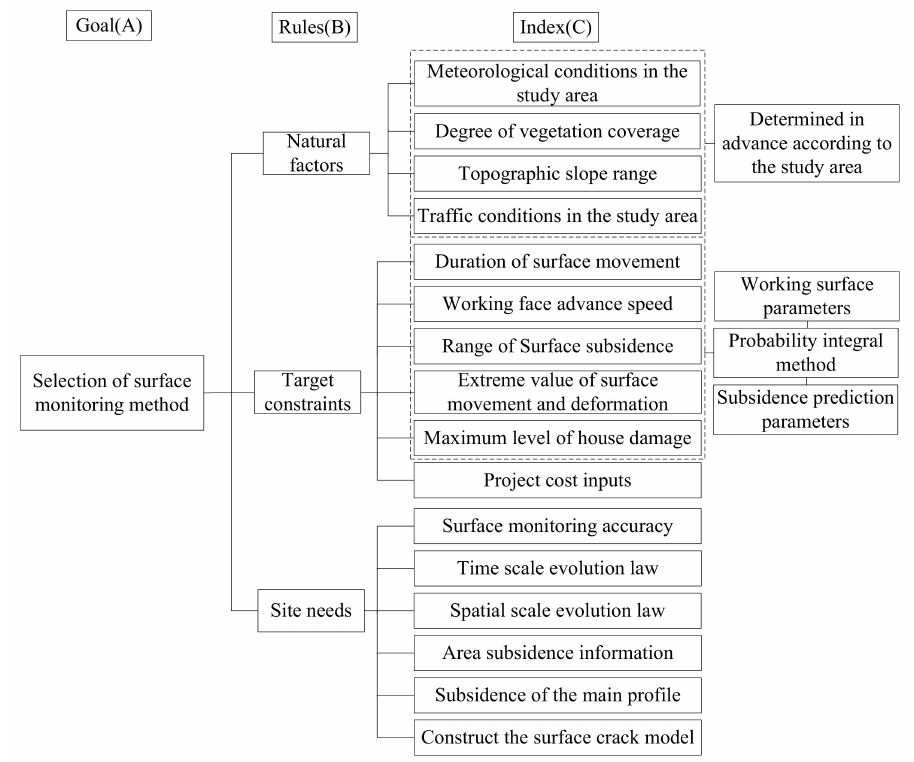
Figure 4. Influencing factors for the preference of surface subsidence monitoring methods